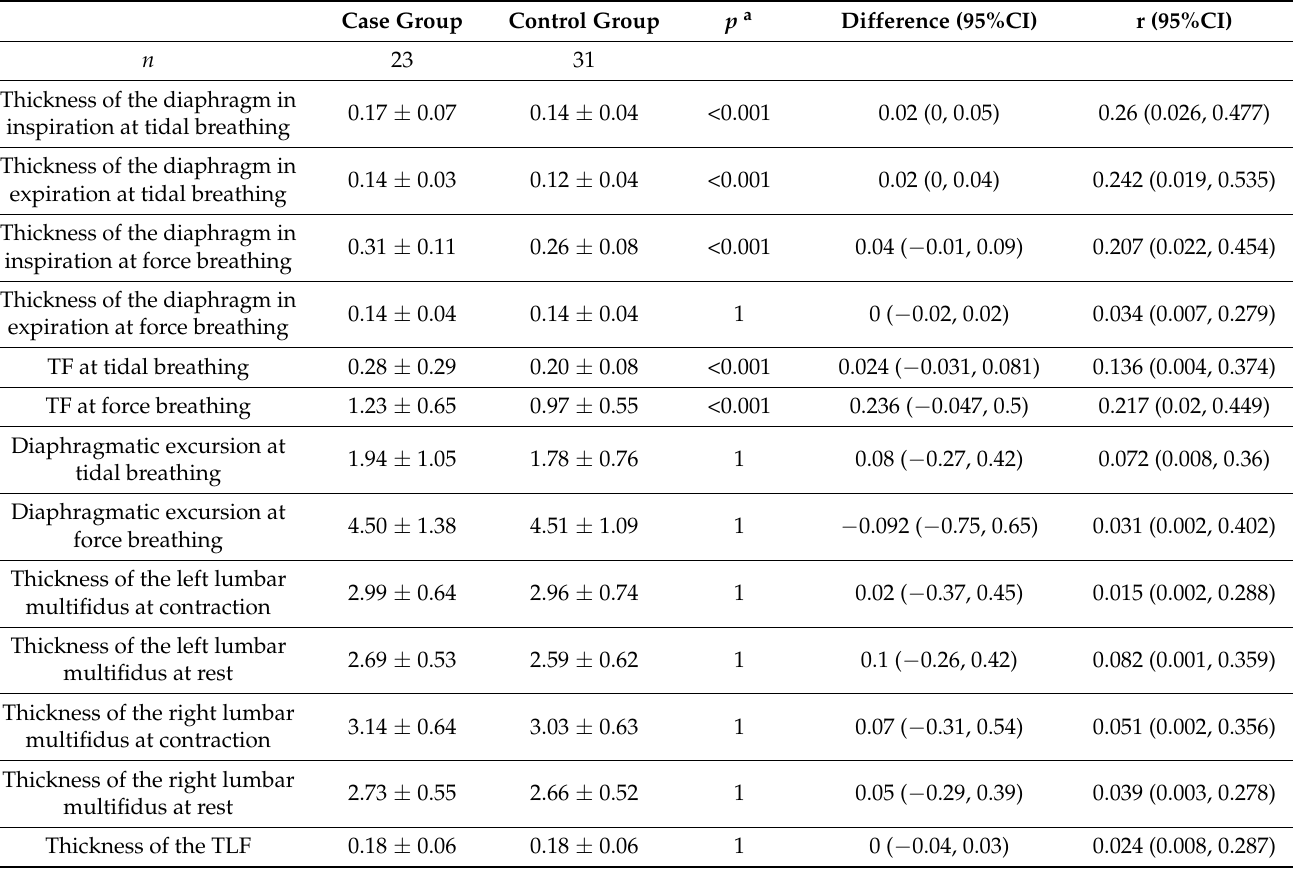
Table 4. Finals results of the study. Data are reported ad the mean ± standard deviation or with absolute and relative values